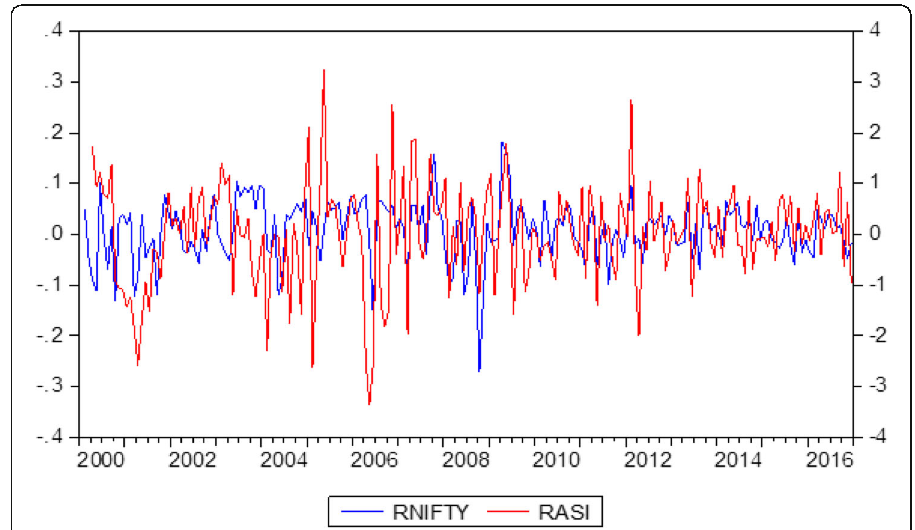
Fig. 2 Investors ’ sentiment and stock index